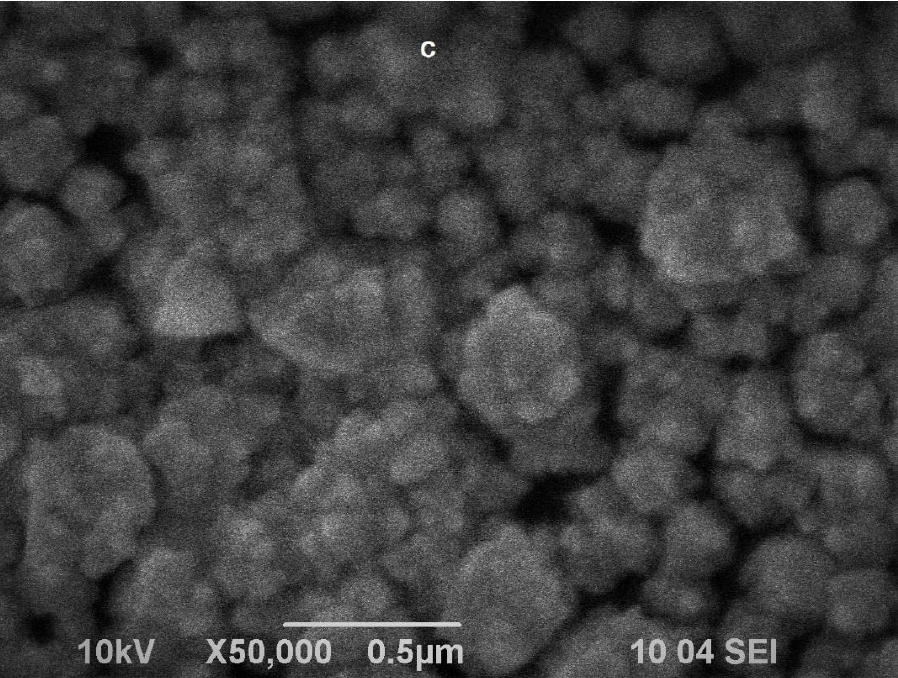
Figure 1. ( A ) Nyquist plot — dependence of the imaginary vs. the real part of the impedance for bare glassy carbon electrode (black squares) and the same electrode after electrodeposition of nanoporous gold (red circles); reference electrode: Ag|AgCl, KCl sat.; electrolyte: 0.1 M KCl containing 5 mM K 4 [Fe(CN) 6 ]/K 3 [Fe(CN) 6 ] as redox probe; frequency range from 100 kHz to 1 Hz. ( B ) Equivalent Randles circuits for the bare (left) and gold-modified (right) glassy carbon electrode. ( C ) SEM image of electrodeposited gold on glassy carbon surface; magnification ×50,000.